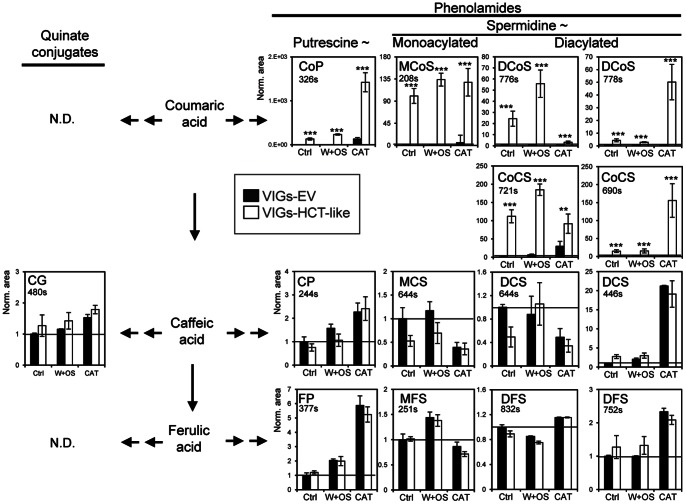

HCT-LIKE-silencing changes levels of selected phenolamides and quinate conjugates.Bar charts summarize relative intensities of selected coumaroyl-, caffeoyl- and feruloyl-based mono-acylated putrescine, mono- and di-acylated spermidine metabolites and chlorogenic acids. No robust m/z signals associated with coumaroyl- and feruloyl- containing quinate conjugates were detected. The results are consistent with a strong diversion of coumaroyl-coA units into coumaroyl-based PA production. Interestingly, the two herbivory elicitation treatments (caterpillar attack and OS elicitation) elicited isomer-specific responses for most of the PA sub-classes. For example, the intensity of some isomers (DCoS at 778 s) was strongly and specifically amplified by direct insect feeding. (** P<0.01, *** P<0.0001, Student's t-test). Ctrl: uninduced control leaves; W+OS: mechanically wounded leaves treated with M. sexta oral secretions; CAT: M. sexta caterpillar-attacked leaves.